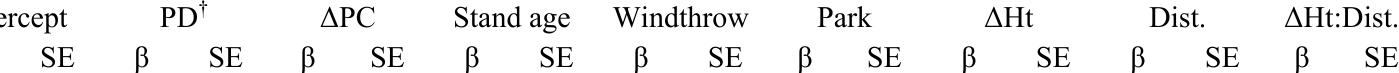
Table A2.5 Parameter estimates for models examining variation in stand-level trends (between circa 1994 and 2014) in abundance Ovenbird in aspen dominated mixedwood forests in central Saskatchewan. 85% Confidence Intervals can be obtained as β ± 1.44* SE. NOTE: Parameter values were rescaled by multiplying with a constant (100) for ease of presentation, divide by 100 to obtain